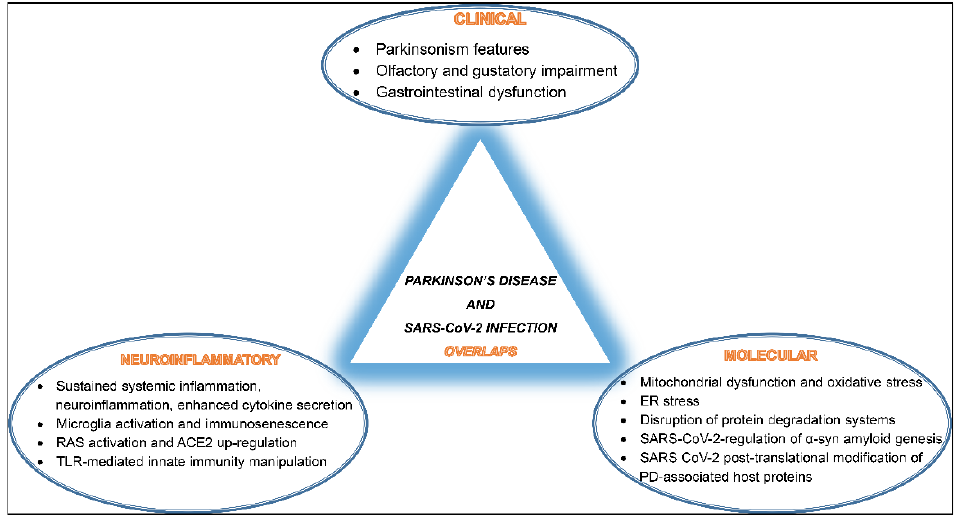
Figure 1. A schematic diagram of SARS-CoV-2 infection and Parkinson’s disease (PD) development overlaps listing shared clinical manifestations, common neuroinflammatory events, and mutually activated molecular pathways .